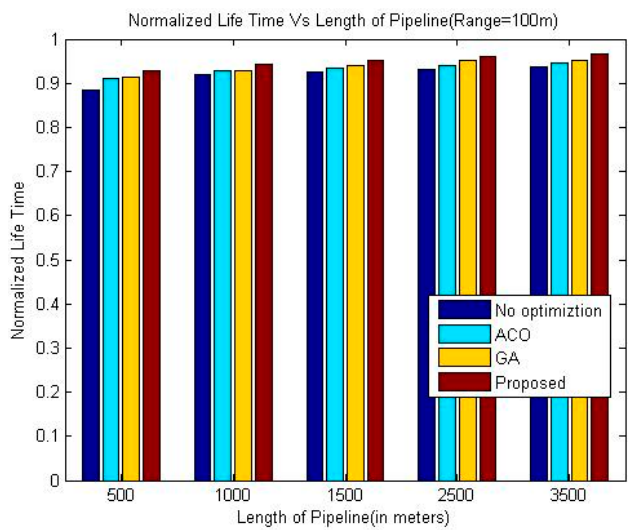
Figure 11. Comparison of Normalized Lifetime (Range 100 m).